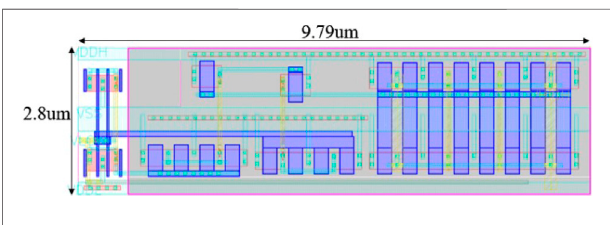
FIGURE 8 | Layout of level